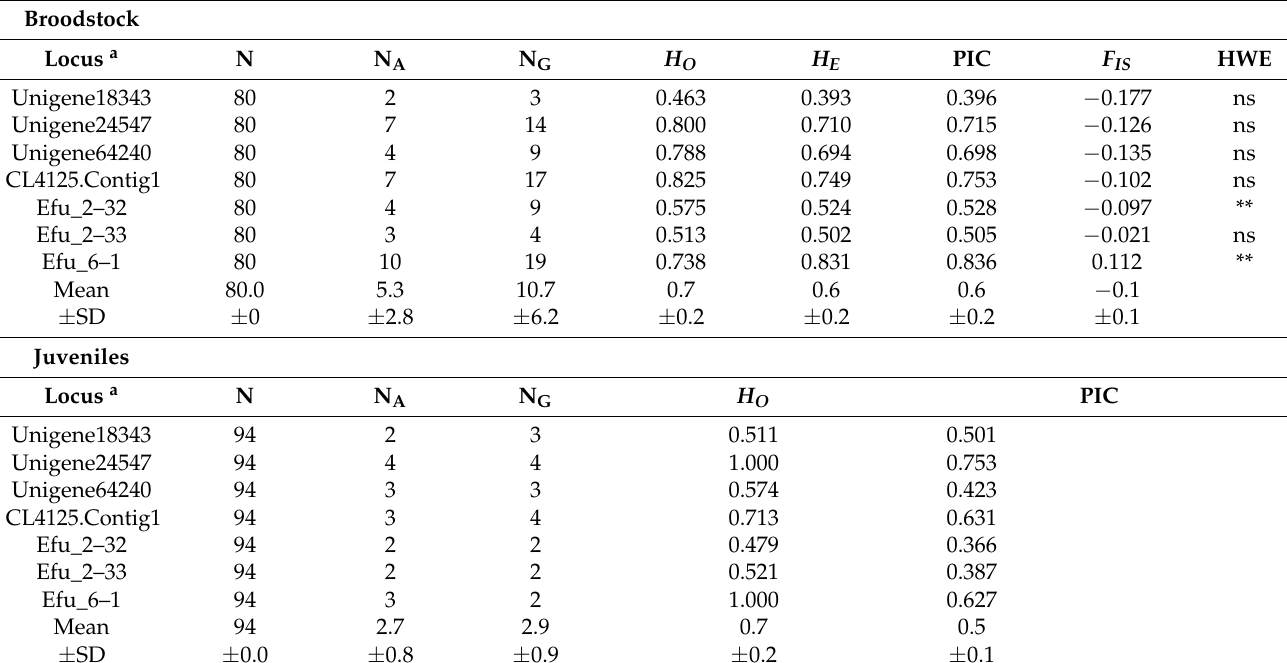
Table 1. Genetic diversity of seven SSR in broodstock and juveniles, and correlation with growth